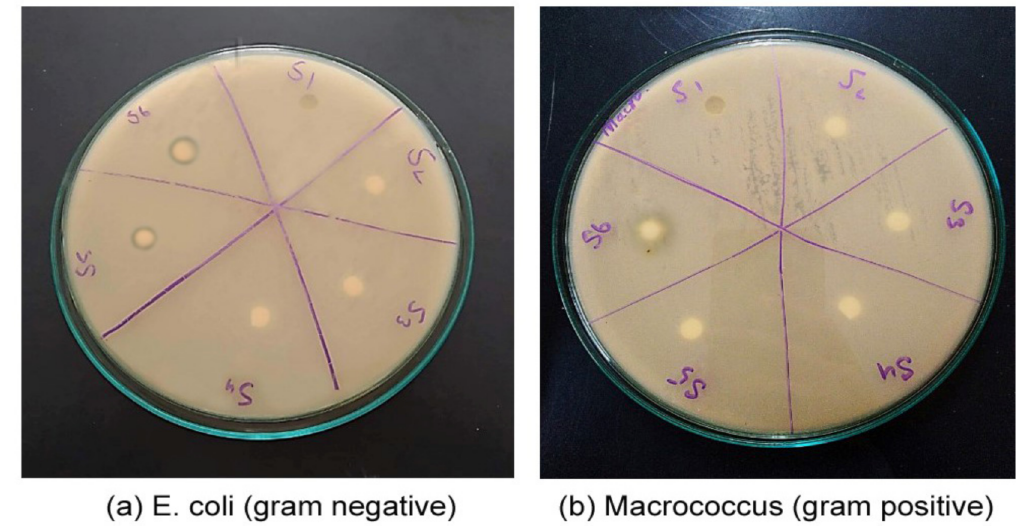
Figure 4. Antibacterial assay of samples against E. coli and Macrococcus .